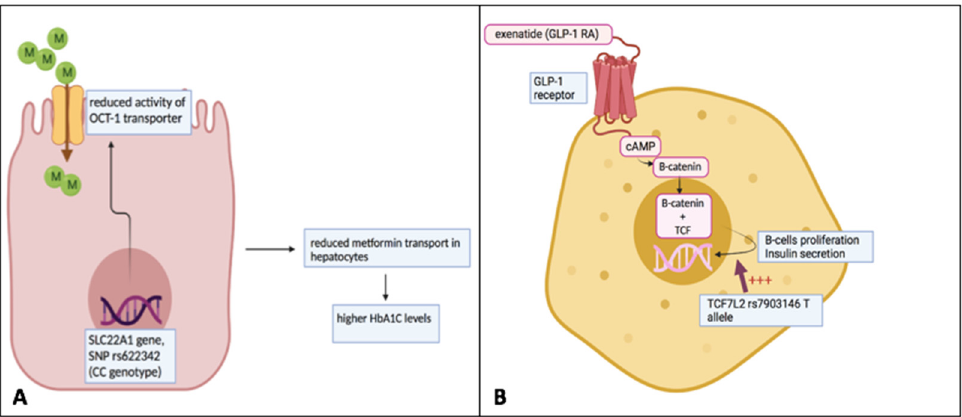
Figure 2. Individual variation of response to metformin and GLP-1 receptor agonists based on pharmacogenomic variants. ( A ) The variant rs622342 (CC) of the SLC22A1 gene leads to a decreased activity of the OCT-1 transporter across the cellular membrane. OCT-1 transporter is responsible for the intra-hepatic transport of metformin. The reduction in metformin amount into these cells may contribute to a minor response to the drug. ( B ) TCF7L2 is involved in the molecular pathway, which facilitates the GLP-1-dependent insulin secretion from pancreatic β -cells. Its genetic variant rs7903146 (T allele) is associated with a positive response to the GLP-1 receptor agonist exenatide. This figure was originally created by the authors.